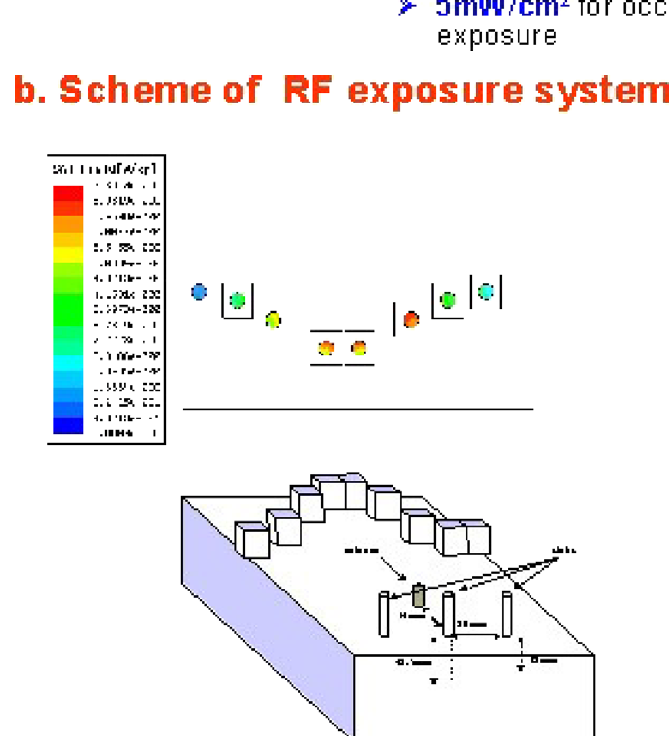
that the epigenetic changes involved in replication pre- cede the onset of increase in aneuploidy. These find- ings suggest that prolonged exposure to non-ionizing radiation increases genomic instability, thus constitut- ing a risk factor for